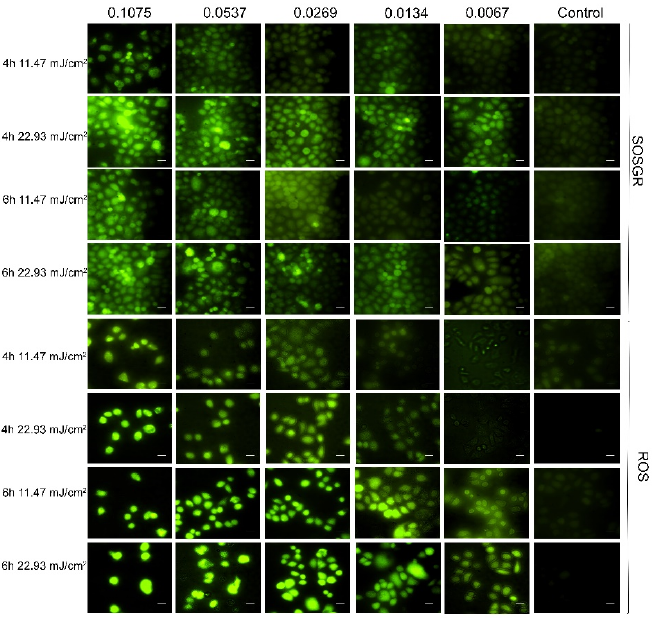
Figure 9. SOG and ROS production induced by PEG-AuS at different concentration and different incubation time (4 h or 6 h) and irradiated with nanosecond pulsed laser with different irradiation dose (11.47 mJ/cm 2 and 22.93 mJ/cm 2 ).